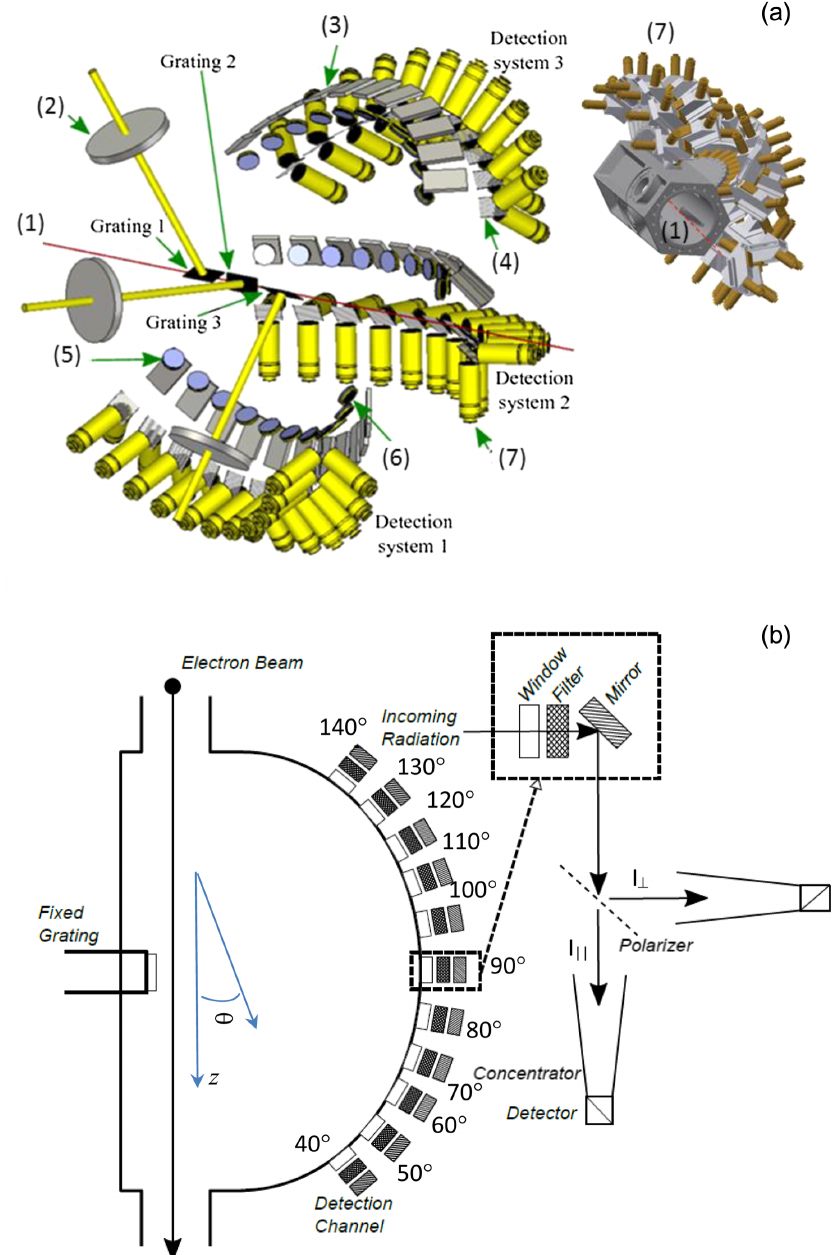
FIG. 4. (a) The 3D technical drawing of the 3 grating monitor (the vacuum chamber is transparent for clarity) with the inset showing the vacuum chamber. The electron beam trajectory is shown by line (1), vacuum flanges (2) support the movable rods which are used to adjust the gratings ’ positions, the mirrors (3) redirect the signal from the targets to the polarization splitters (4). The radiation emerges through the silicon windows (5) and narrow passband filters (6) can be used to filter unwanted frequencies. The signals are measured by a detection system consisting of detectors (7) and Winston cones (8). The inset illustrates the vacuum chamber with the vacuum ports, detectors (7) and beam trajectory (1); (b) the schematic of the cSPr monitor. The background and cSPr signals are separated via polarization measurements, as shown in the